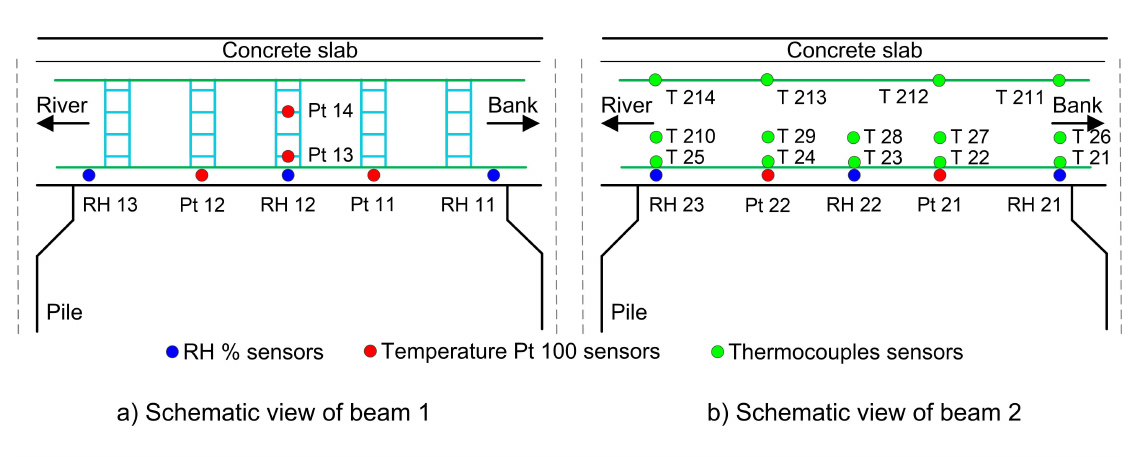
Figure 7. Temperature and humidity sensors in beam 1 and beam